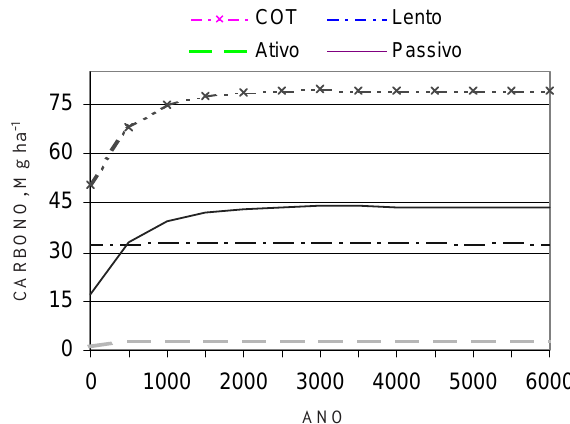
Figura 1. Estoques de carbono orgânico total (COT) e dos compartimentos de carbono orgânico de um Argissolo Vermelho-Amarelo (0-20 cm), obtidos por meio da simulação de equilíbrio realizada pelo modelo